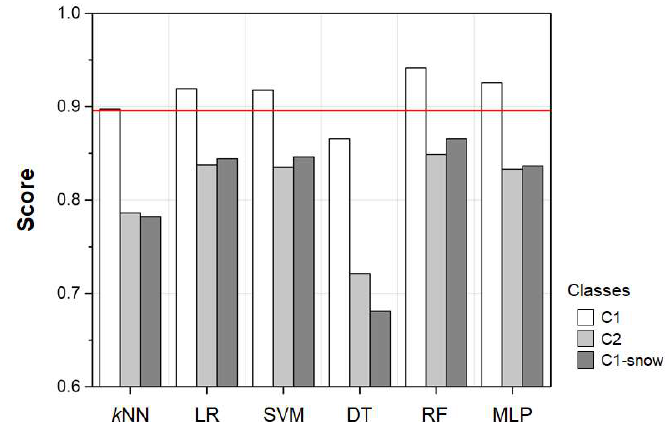
Figure 7. The results of independent model evaluation regarding different class sets. The red solid line indicates the classification success rate of the baseline method.